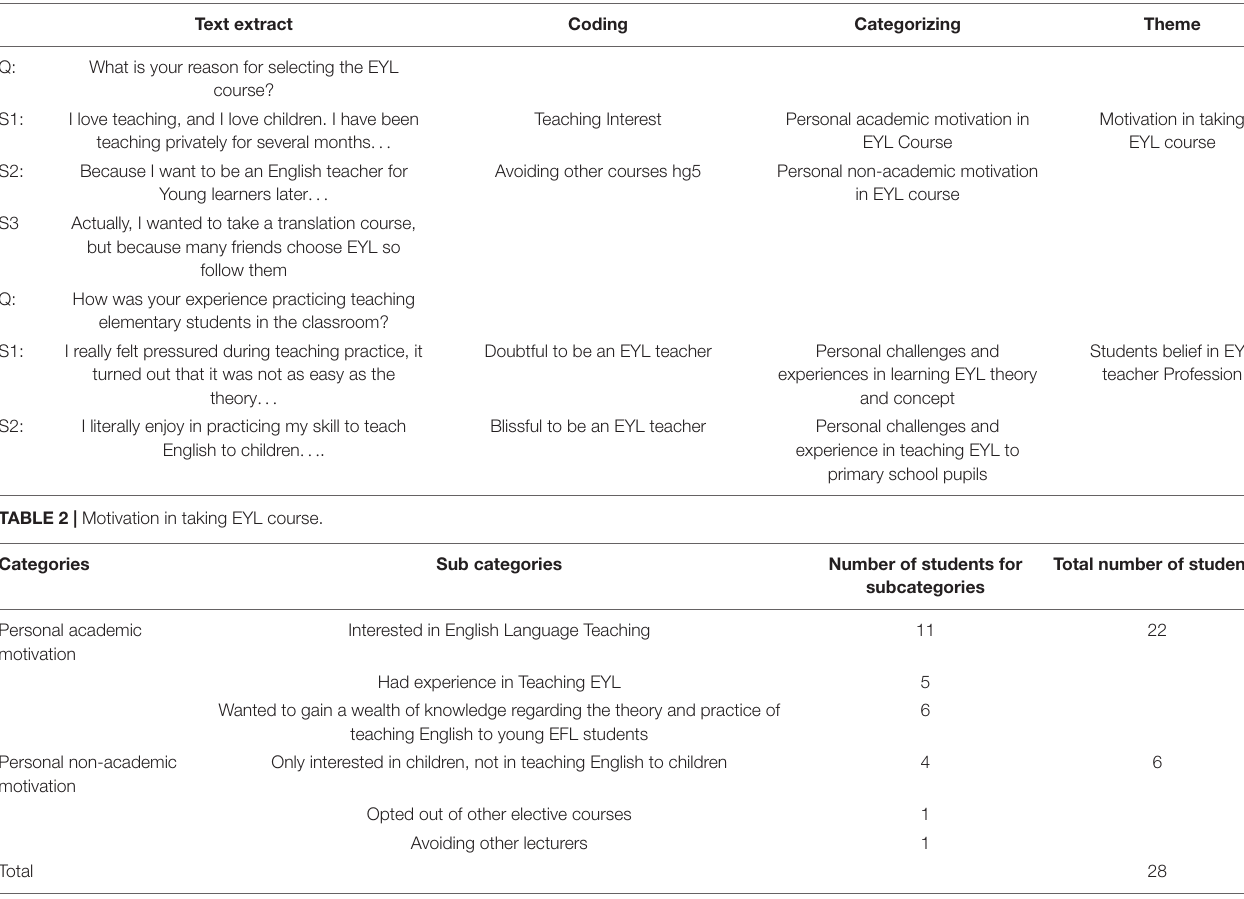
TABLE 1 | Example of coding in data analysis. Text extract